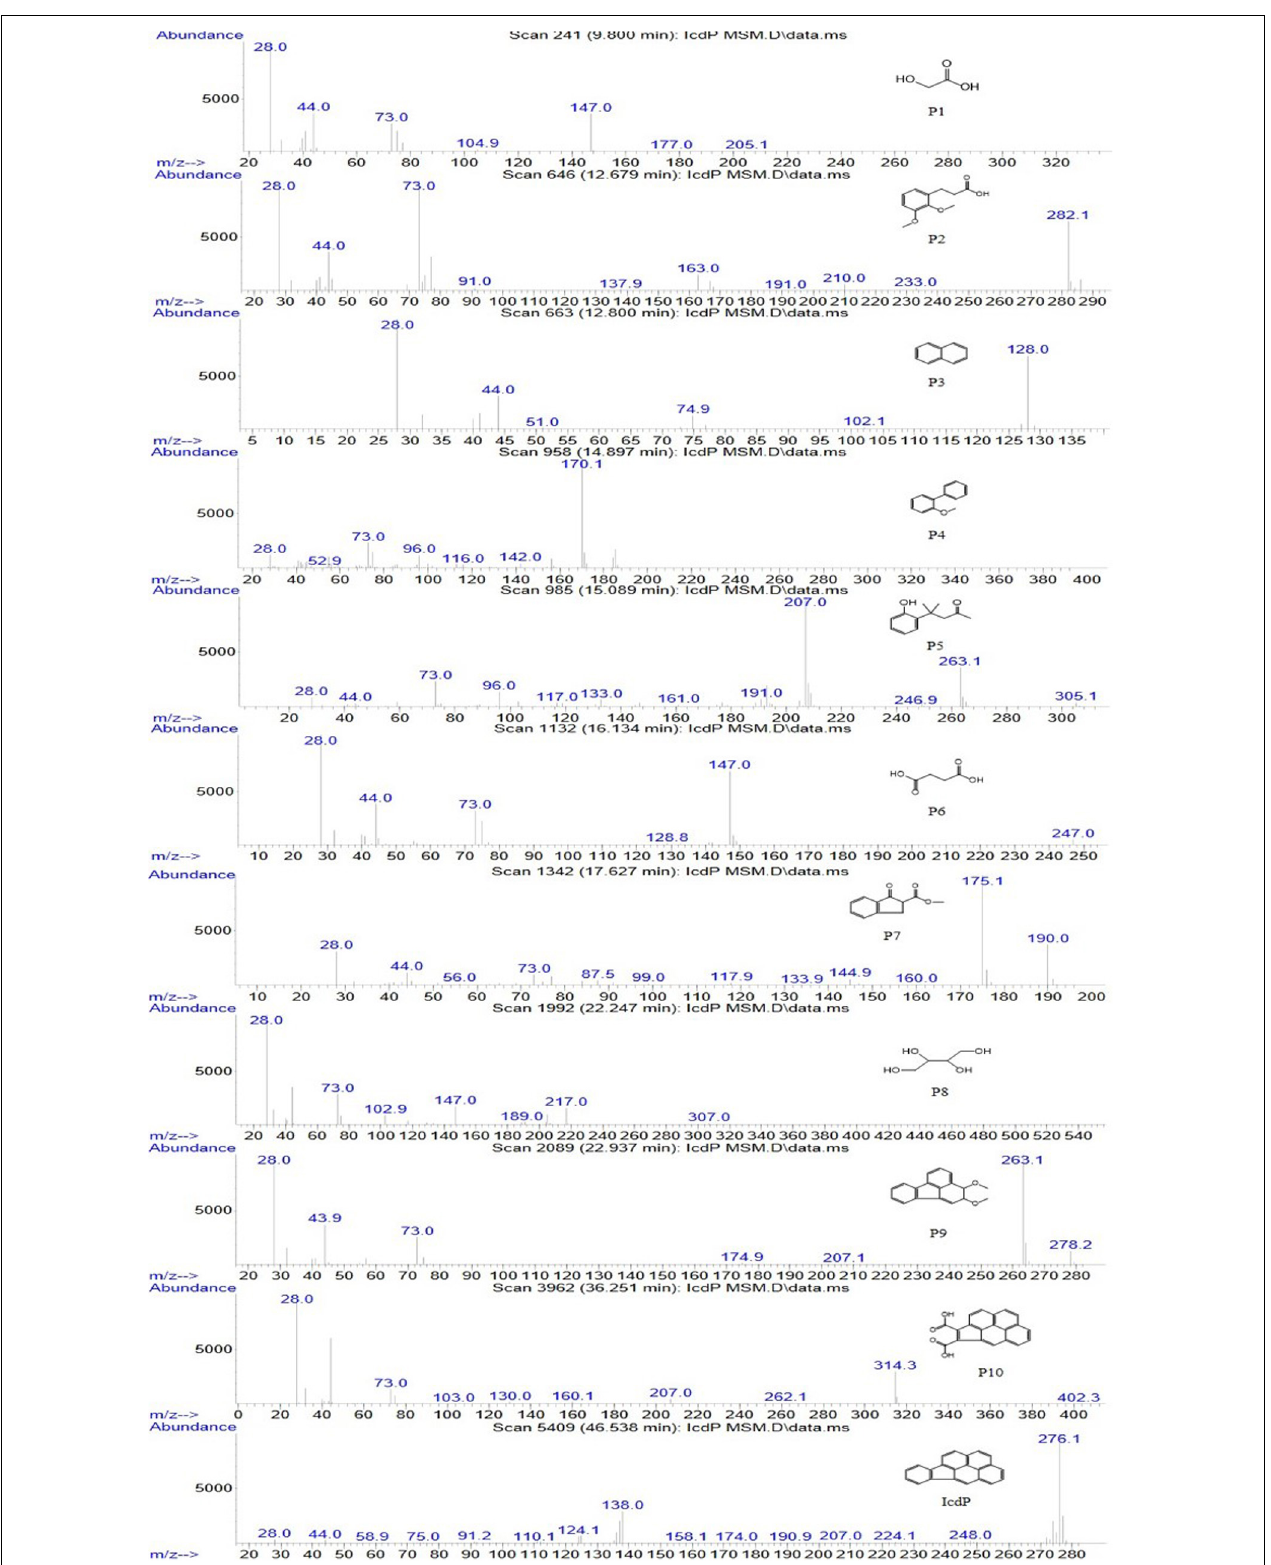
FIGURE 2 | Mass spectra and structures of intermediates in the IcdP degradation pathway in strain IcdP1.